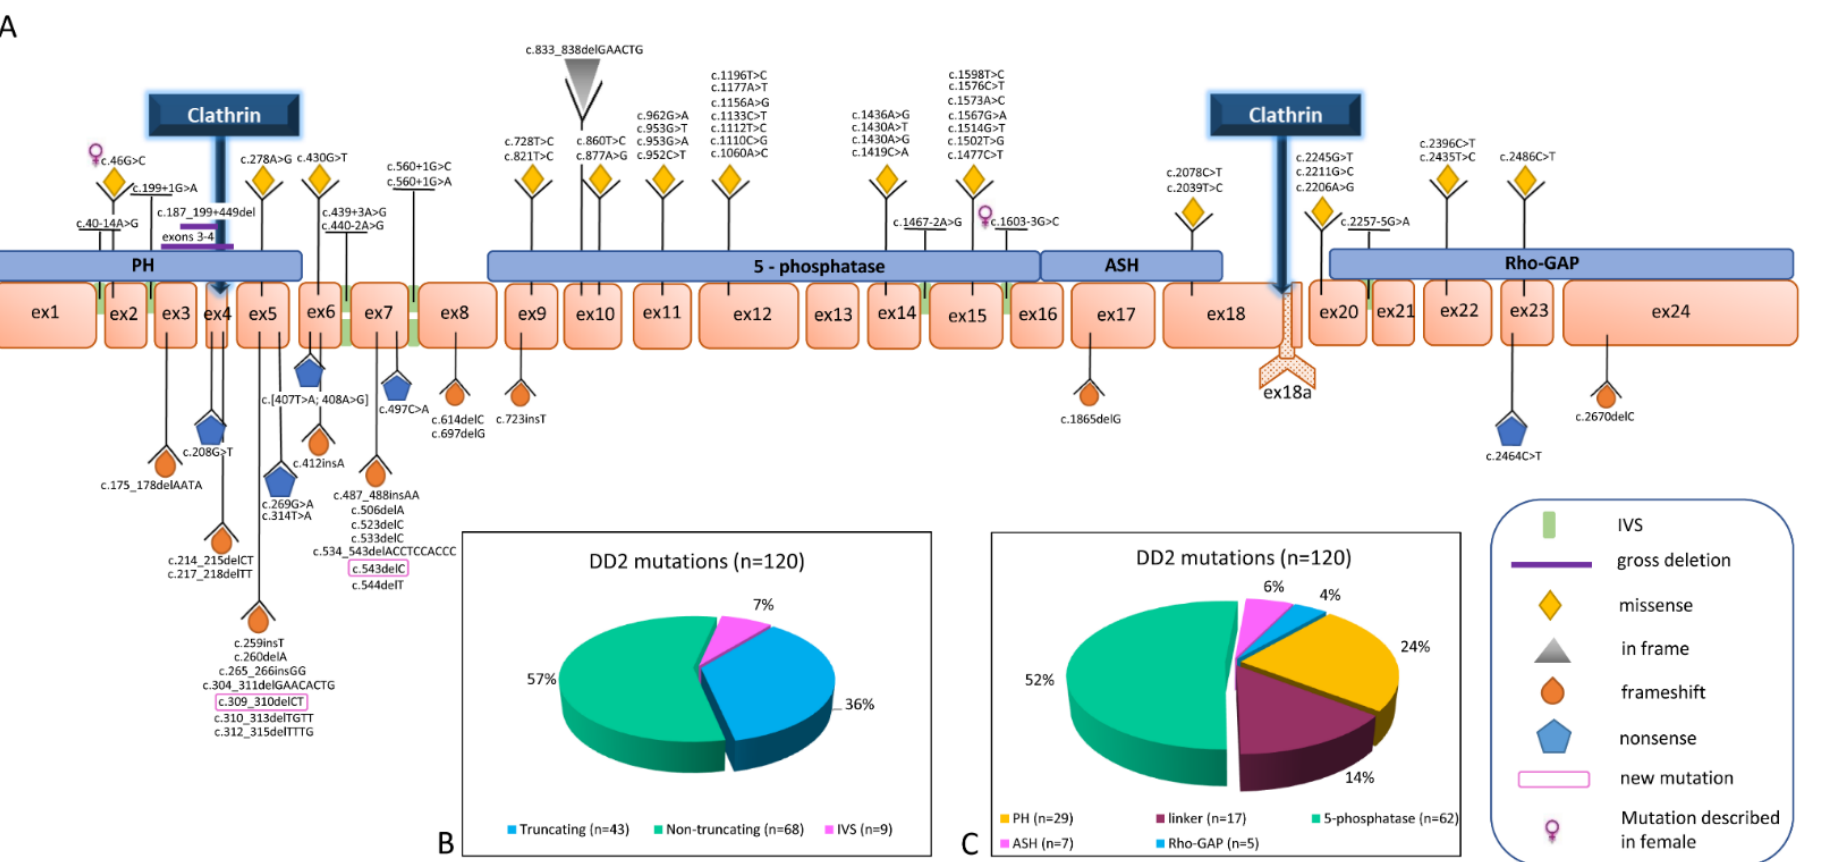
Figure 2. OCRL mutations described in DD2 subjects. ( A ). Genogram showing OCRL mutations in DD2 cases. Numbering is according to the cDNA sequence (GenBank entry NM_000276.4). The ( A ) of the ATG of the Methionine initiation codon is defined as nucleotide 1. ( B ) Distribution of DD2 mutations by type: truncating (nonsense and frameshift), non-truncating (missense and in-frame) or splice site mutations (IVS). ( C ) Distribution of DD2 mutations by OCRL protein domain affected.